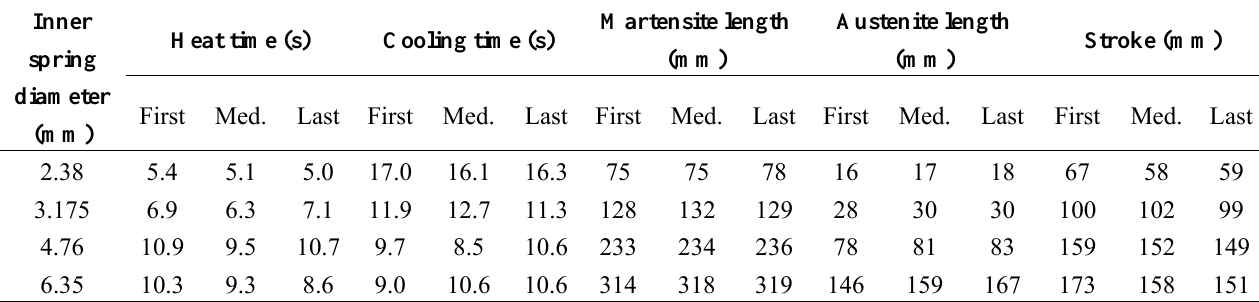
Table 5. The averaged first, median and last values for the spring diameter manipulation. Inner